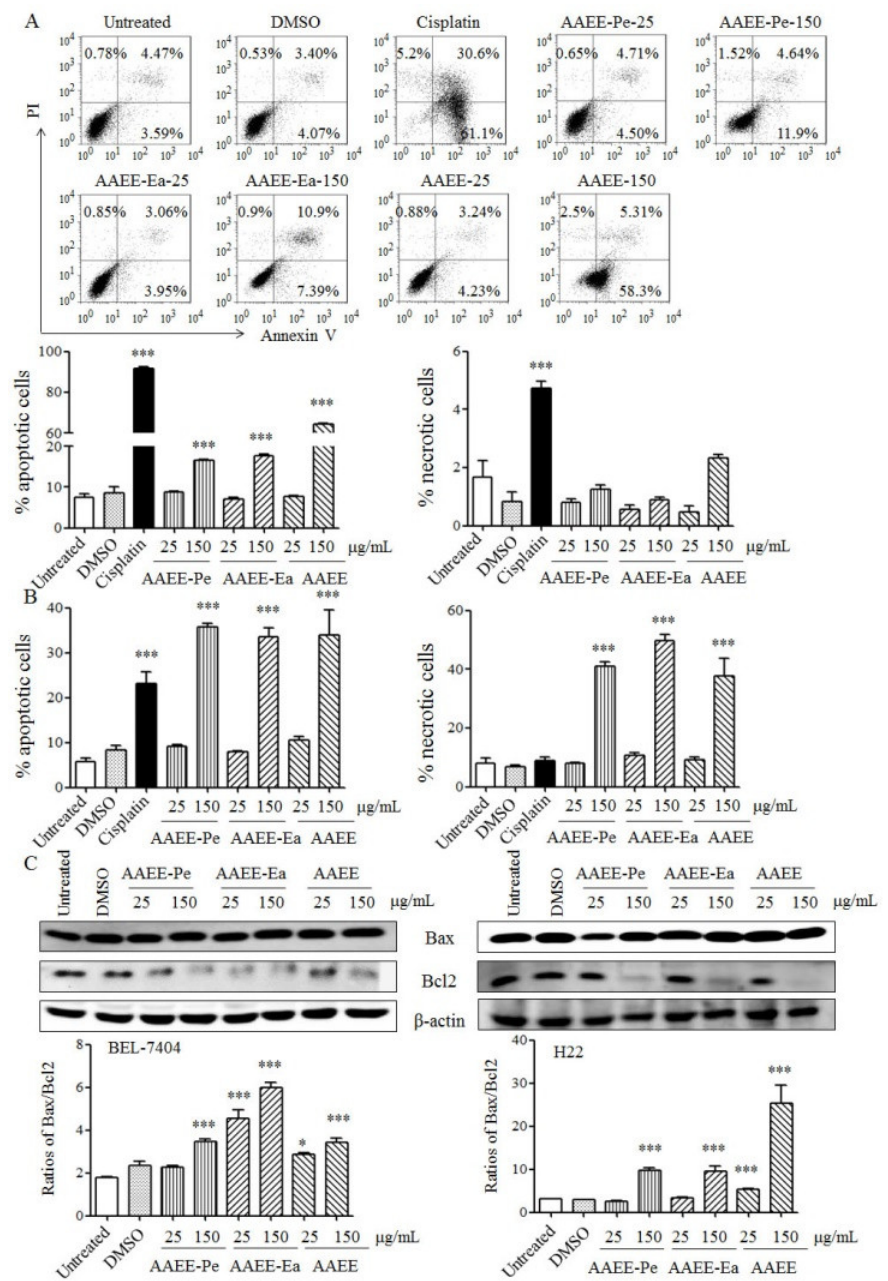
Figure 2. AAEE, AAEE-Pe, and AAEE-Ea induced apoptosis in BEL-7404 and H22 cells. Cells were treated with different concentrations of AAEE, AAEE-Pe, and AAEE-Ea for 24 h. After staining with Annexin V and PI, BEL-7404 ( A ) and H22 ( B ) cells were analyzed by flow cytometry. ( C ) Proteins were isolated, and the levels of Bax and Bcl-2 were analyzed by Western blot. * p < 0.05; *** p < 0.001 compared to Untreated.